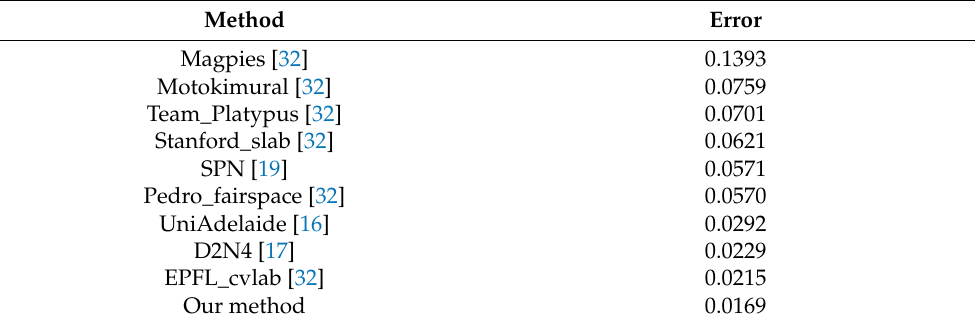
Table 3. Comparison results of pose estimation.